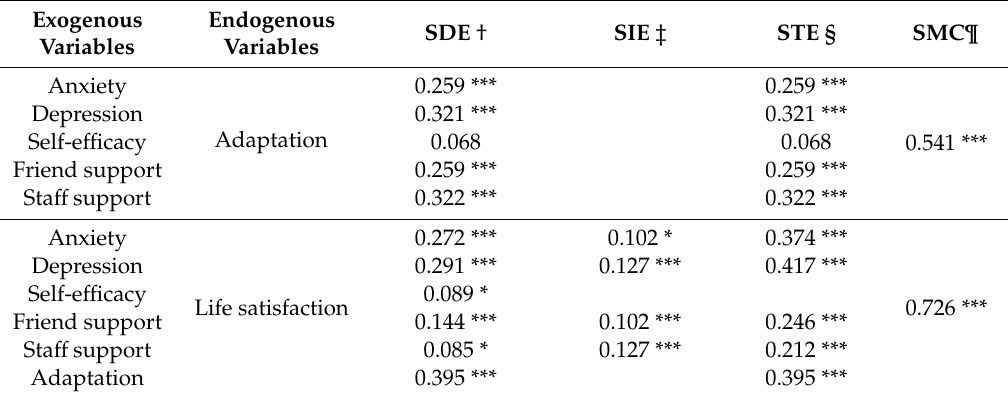
Table 4. Standardized direct, indirect, and total e ff ects for the modified final